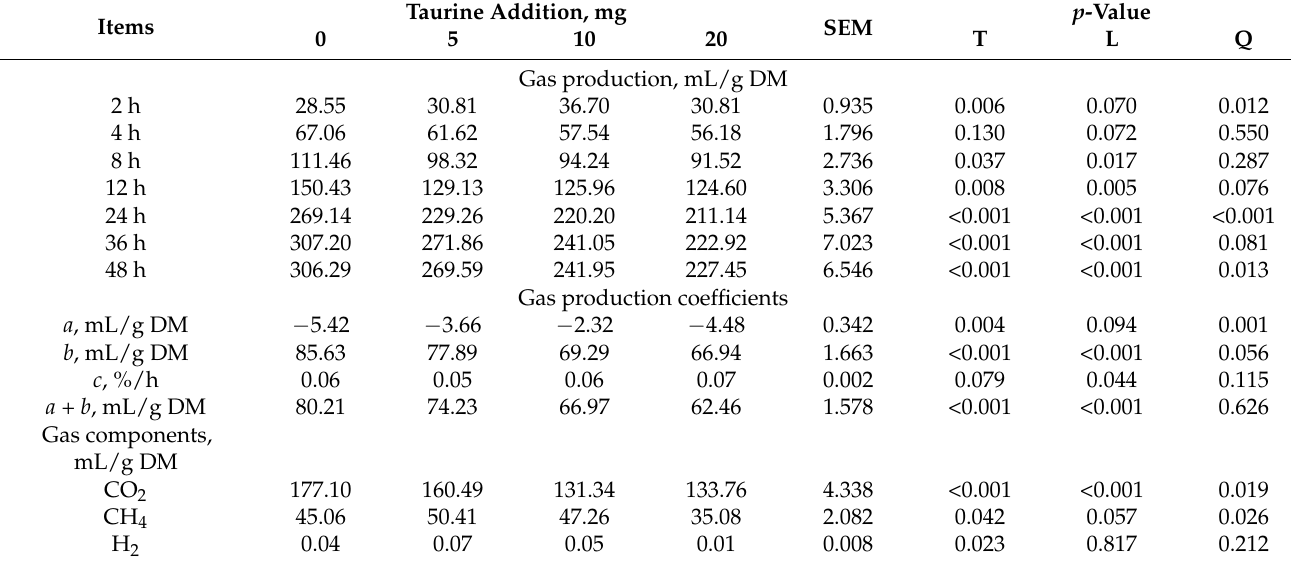
Table 6. Effects of taurine on in vitro rumen gas production (Trial